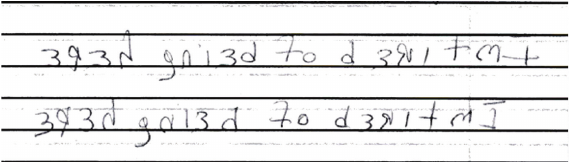
Figure 1: Sentence written by Ms. A.